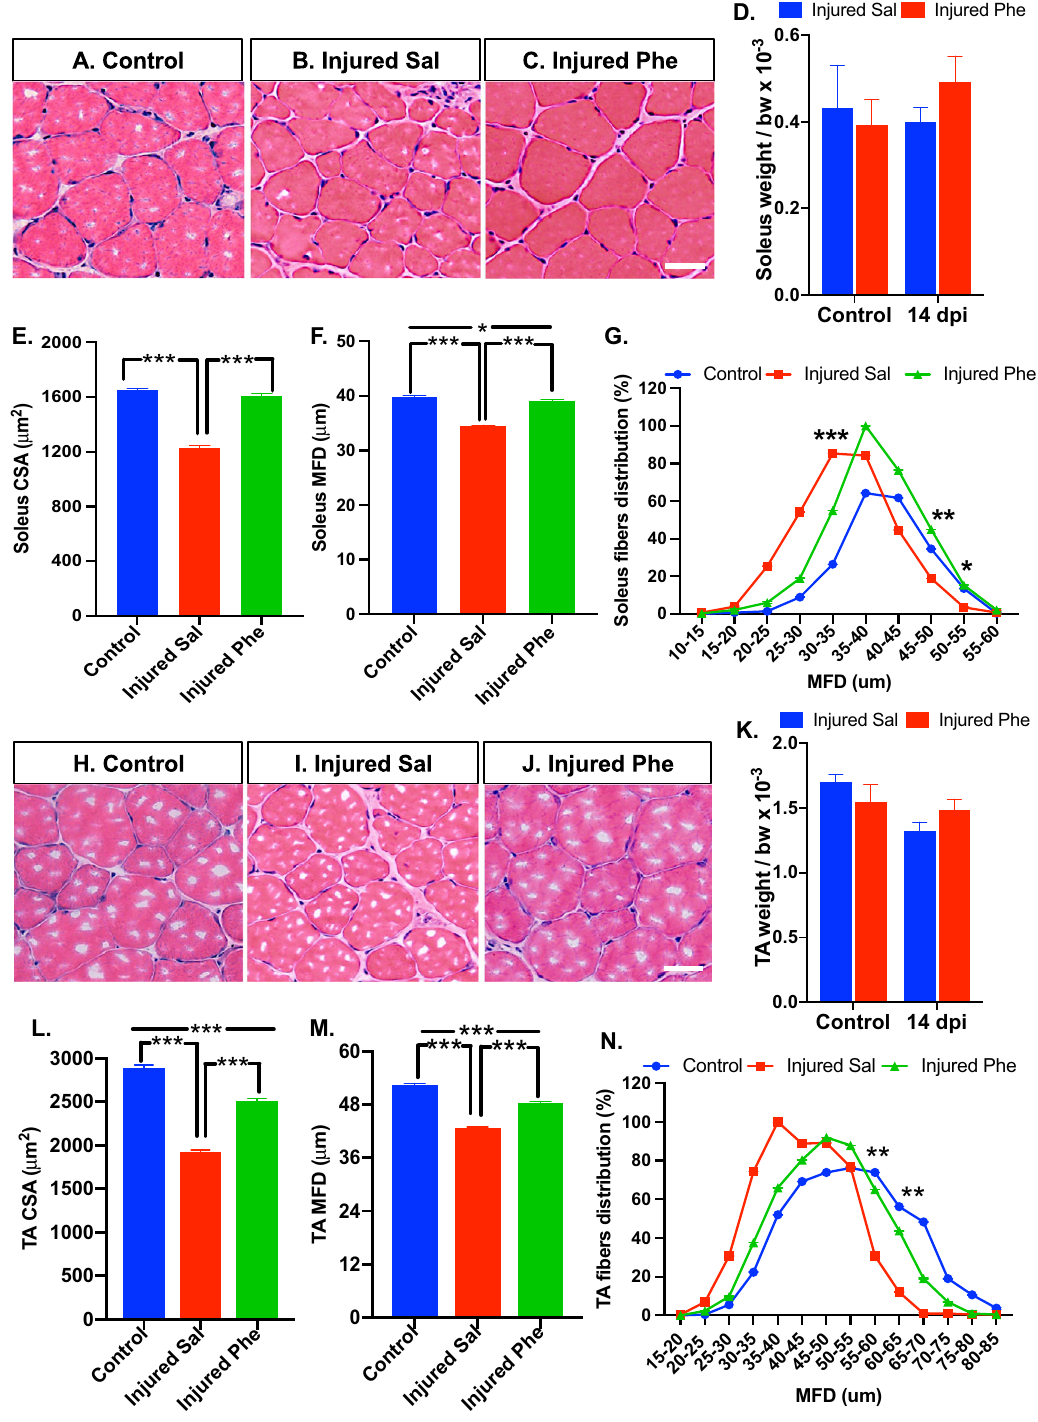
Figure 3. Effect of in vivo phentolamine treatment on post-injury soleus and TA muscle morphology. ( A – C ) Representative images of soleus muscle cross-sections, with hematoxylin–eosin (H&E) staining (scale bar, 100 µm). ( D ) Soleus muscle weigh normalized by body weight × 10 –3 (control n = 5, 14 dpi n = 8 per treatment group). ( E ) Quantification of soleus cross-section area (CSA) ( n = 900 fibers from 4 individual mice per treatment group). ( F ) Quantification of soleus minimal Feret’s diameter (MFD) ( n = 900 fibers from 4 individual mice per treatment group). ( G ) Distribution of soleus muscle fibers against MFD ( n = 4 per group). One-way ANOVA followed by Benjamini and Hochberg correction was performed to calculate statistical significance. ( H – J ) Representative images of TA muscle cross-sections, with hematoxylin–eosin (H&E) staining (scale bar, 100 µm). ( K ) TA muscle weigh normalized by body weight × 10 –3 (control n = 5, 14 dpi n = 8 per treatment group). ( L ) Quantification of TA CSA ( n = 1100 fibers from 4 individual mice per treatment group). ( M ) Quantification of TA MFD ( n = 1100 fibers from 4 individual mice per treatment group). ( N ) Distribution of TA muscle fibers against MFD ( n = 4 per group). One-way ANOVA followed by Benjamini and Hochberg correction was performed to calculate statistical significance. Data are shown as Mean ± SEM (*p ≤ 0.05, **p ≤ 0.01, ***p ≤